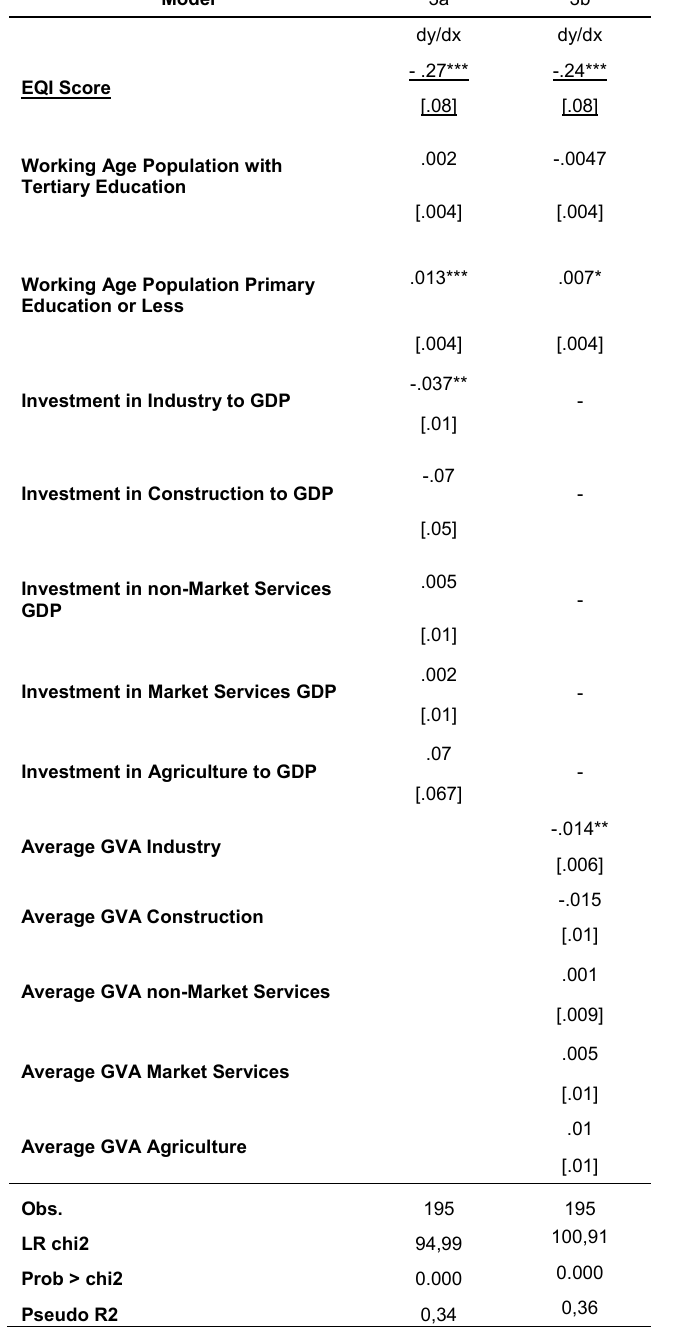
Table 4. Marginal effects on probability Y=1|X. Group B + Group